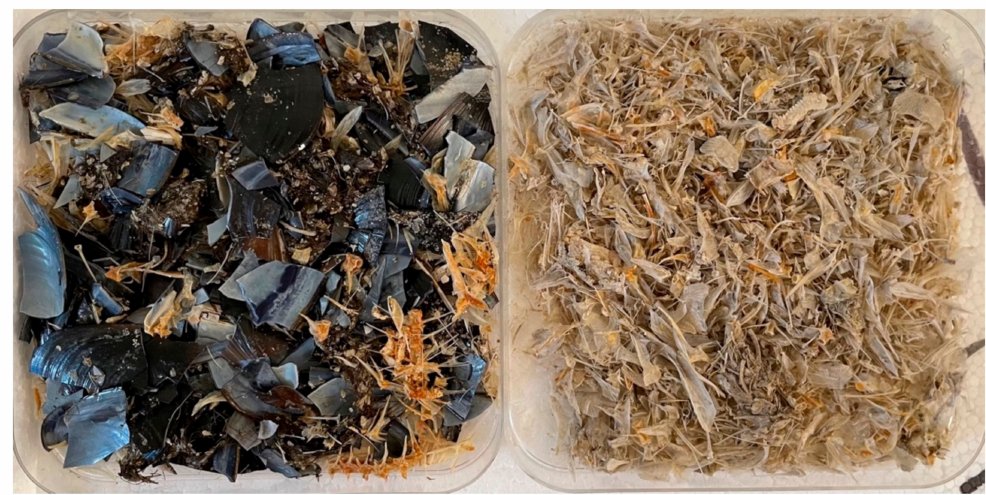
Figure 5. Gastrointestinal content of an adult female from the Adriatic Sea who predominantly fed on blue mussels and fish.